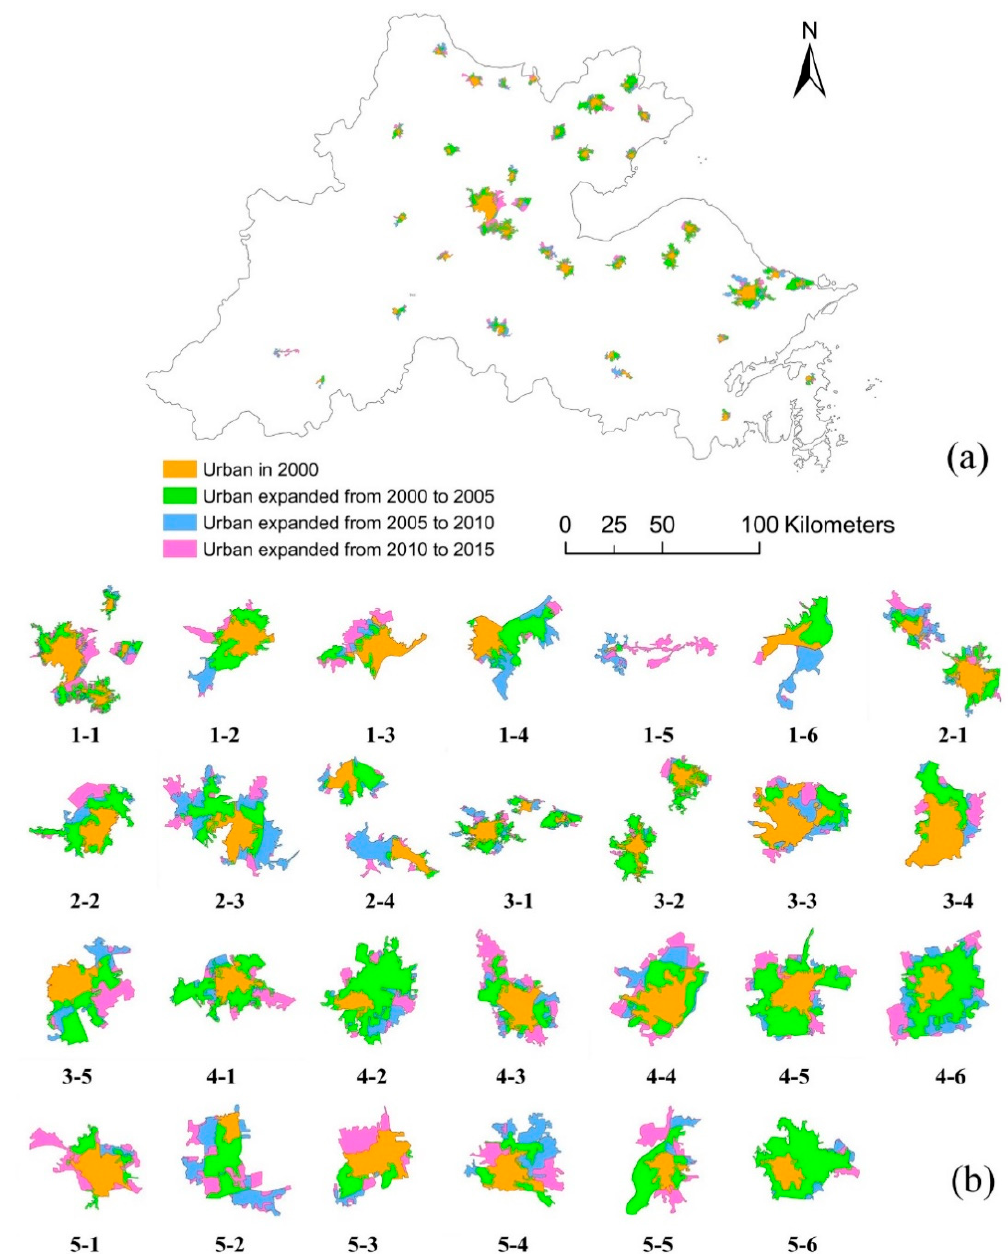
Figure 4. Urban expansion from 2000 to 2015 in the Hangzhou Bay area. ( a ) All urban areas; ( b ) each urban area.